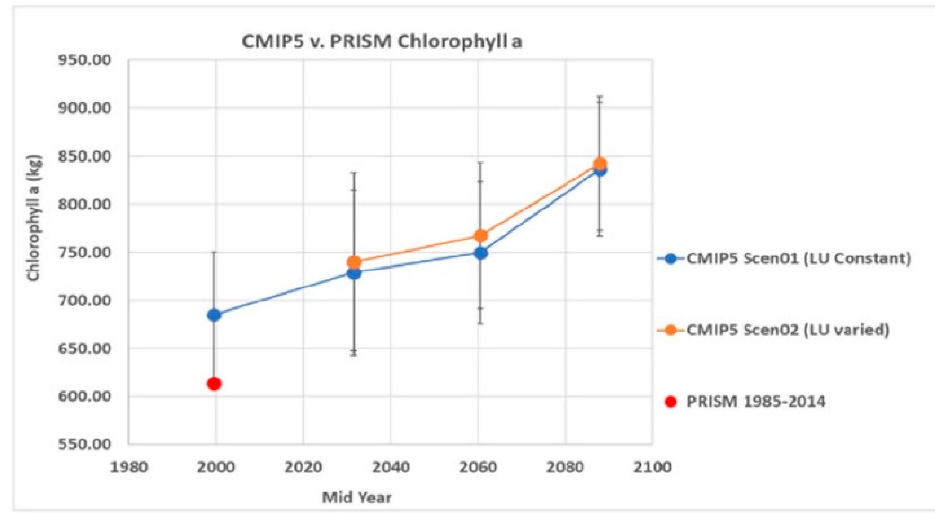
Figure 9. PRISM vs. average of 20 CMIP5 GCMs chlorophyll a (2018–2100).